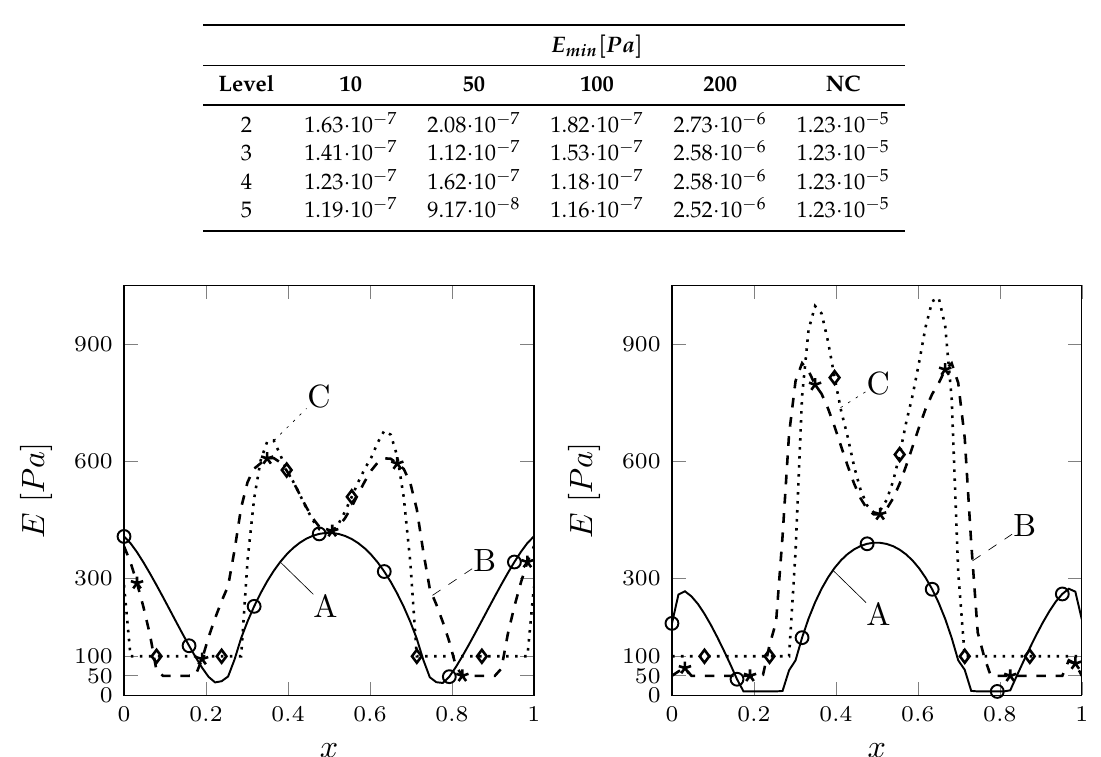
10 3 . · 10 3 . The reference case with no control is labeled with NC. ·